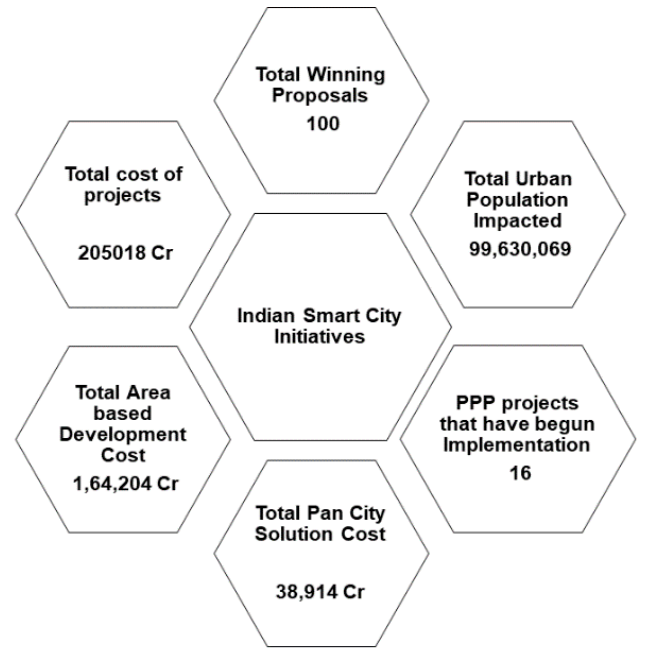
Figure 2. India’s Commitment towards Smart City Initiatives.